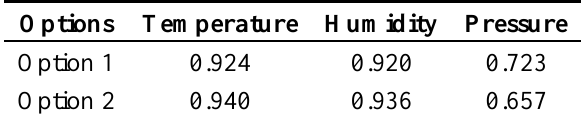
Table 5. Confirmatory experiment: correlation